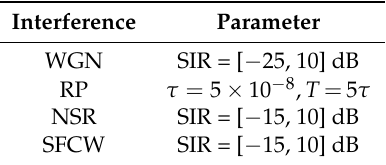
Table 2. Interference signal simulation parameter